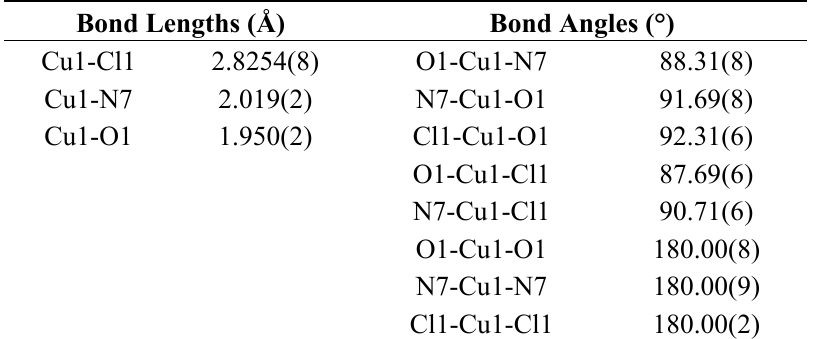
Table 6. Selected bond lengths and bond angles in copper(II) complex 9 .